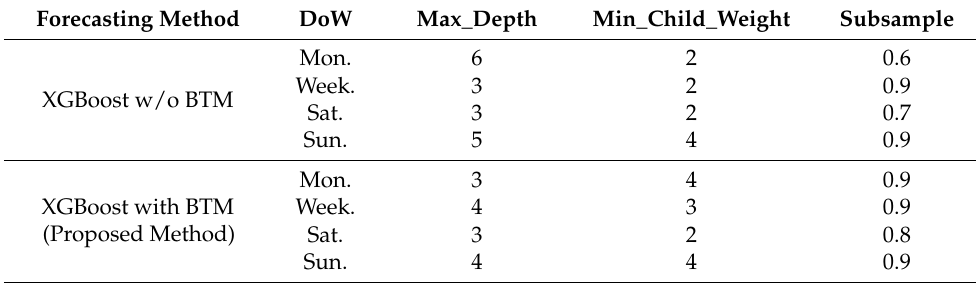
Table 4. Hyper-parameter search